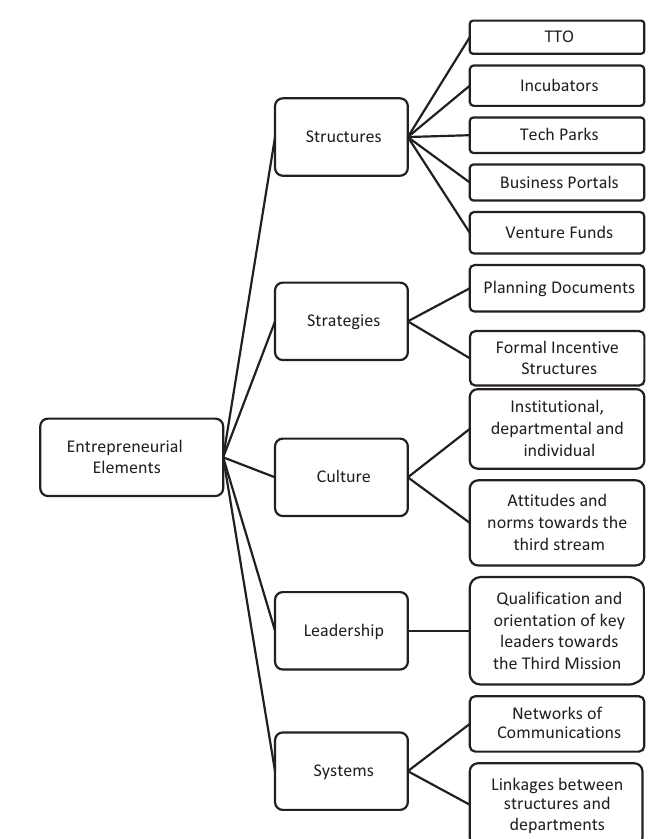
Stage 3: Identifying the relationships between the final-level goals and rankings the goals. Stage 4: Creating a list of candidate projects and programs to meet the objectives. Stage 5: Creating a portfolio of projects by a multi-objective mathematical model.